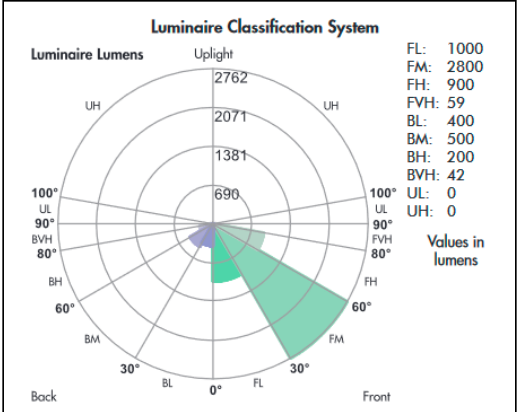
Figure 2. The luminaire classification system of LEDs. Energies 2020 , 13 , x FOR PEER REVIEW